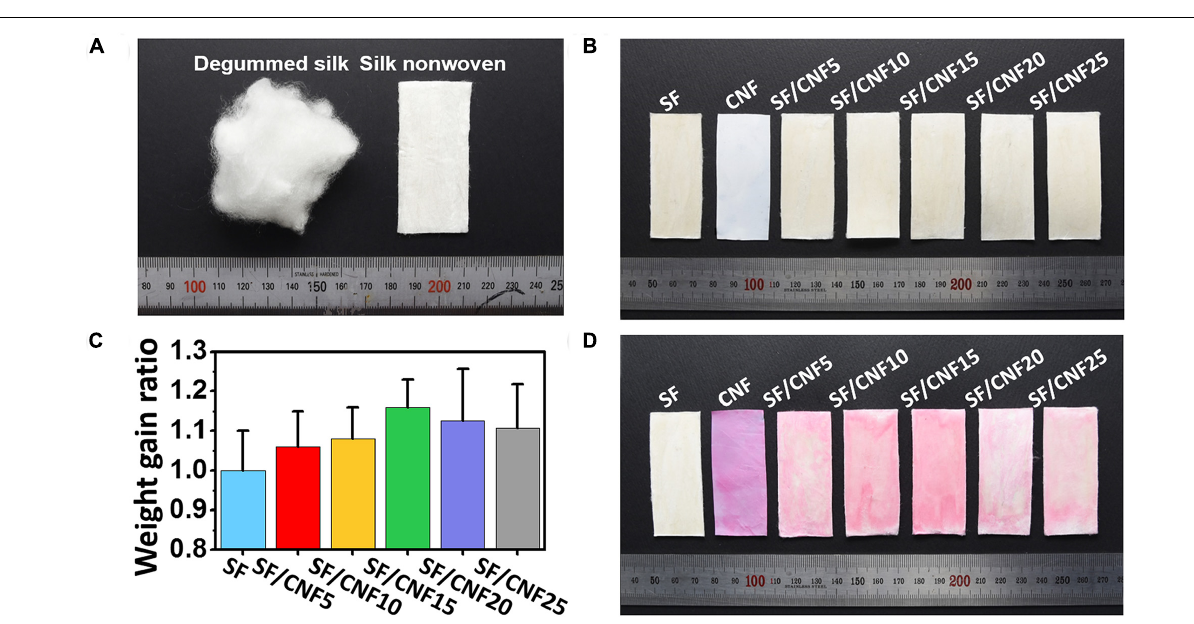
fabric by reduced weight gain ratio of SF/CNF20 and SF/CNF25 compared to